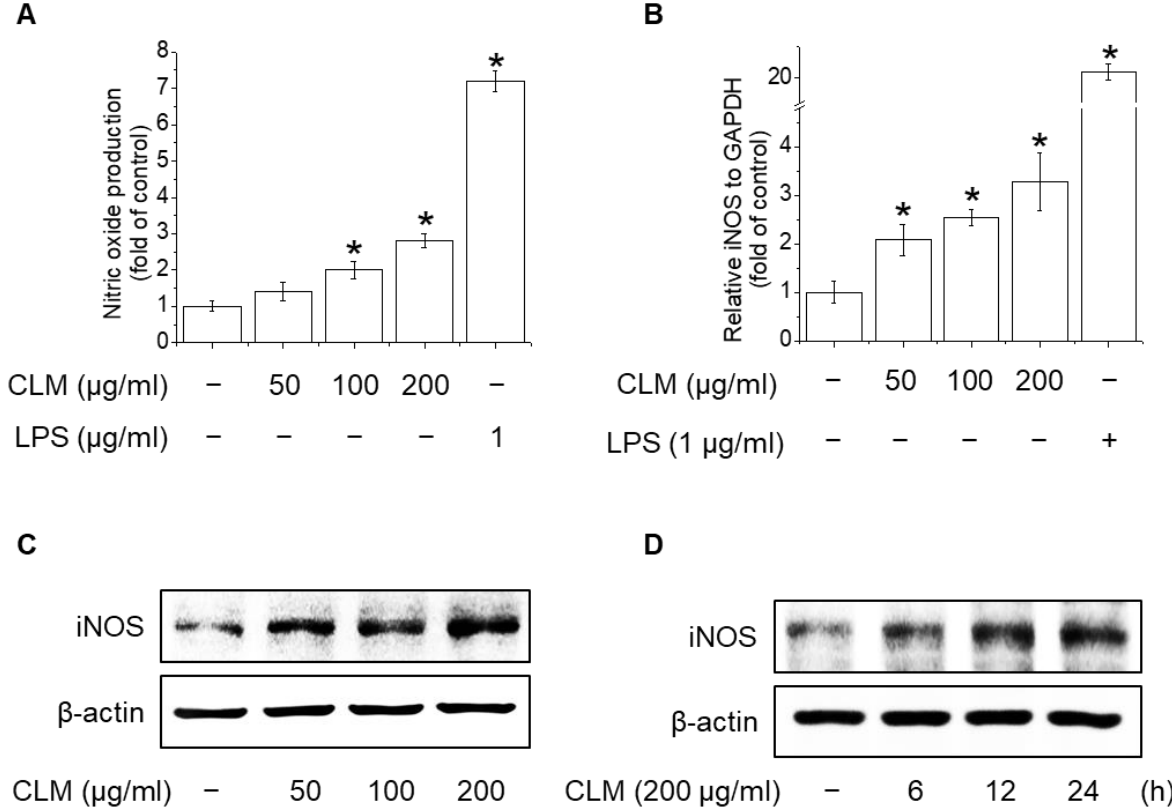
Figure 6. Effects of CLM on NO production and iNOS expression in macrophages. ( A – C ) RAW264.7 cells were seeded in a 12-well plate at a density of 2 × 10 5 cells/mL for 24 h, cultured at 37 °C and 5% CO 2 , and treated with different concentrations of CLM (50, 100, and 200 μ g/mL) and LPS (1 μ g/mL) for 24 h. ( A ) Supernatants were harvested 24 h later and assayed for NO. ( B ) Total cellular RNA was extracted for RT-PCR with mouse iNOS primers. GAPDH confirmed the integrity and equal loading of RNA. ( C ) Cell lysates were electrophoresed and the expression of iNOS was detected with an iNOS antibody. ( D ) Cells were exposed to 200 μ g/mL CLM and total cell lysate was extracted at the indicated times. The expression of iNOS was detected with an iNOS antibody; β -actin was measured as a loading control. * p < 0.01 vs. control group.